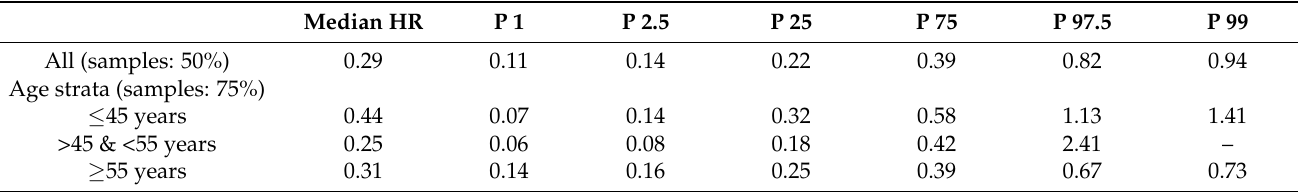
Table 4. Distribution of the hazard ratios (point estimates) in a resampling analysis with 1000 ran- dom samples (each of them comprising only 50% of the full cohort) and in another 1000 random samples within each age stratum (each of them comprising only 75% of that stratum), obtained from the Cox model with repeated measurements of the MDS (>6 vs. <3 points), using IPW for controlling potential confounders.